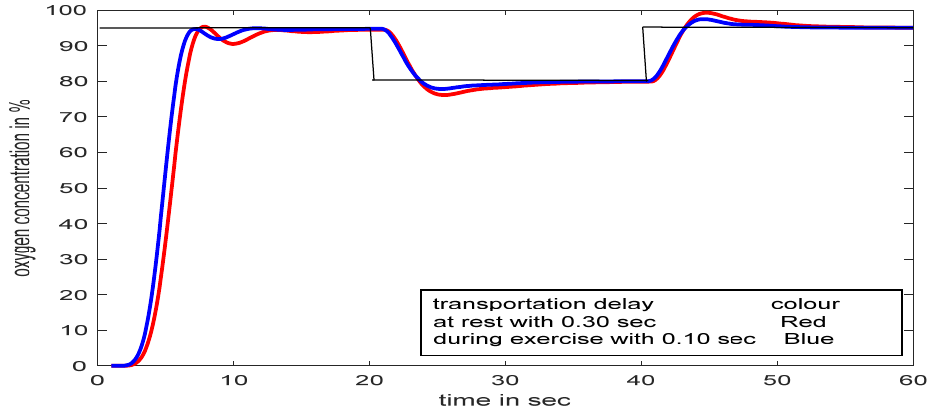
Figure 20. Process responses with SFPIMRAC for time delay and load/set ‐ point variations.